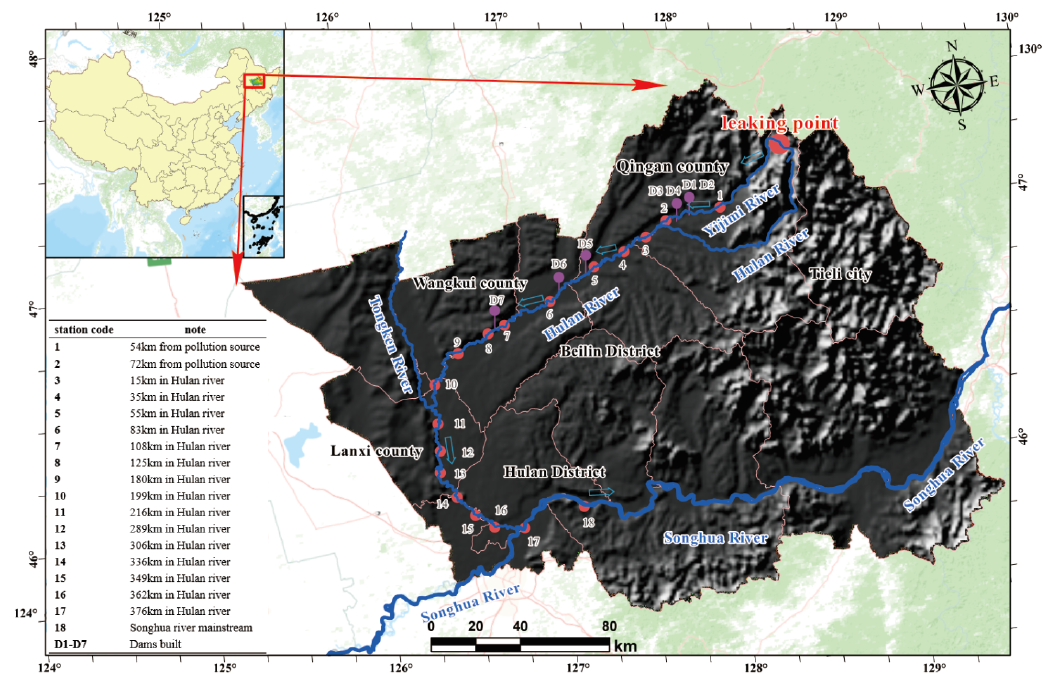
Figure 2. The study area of Yichun Luming.